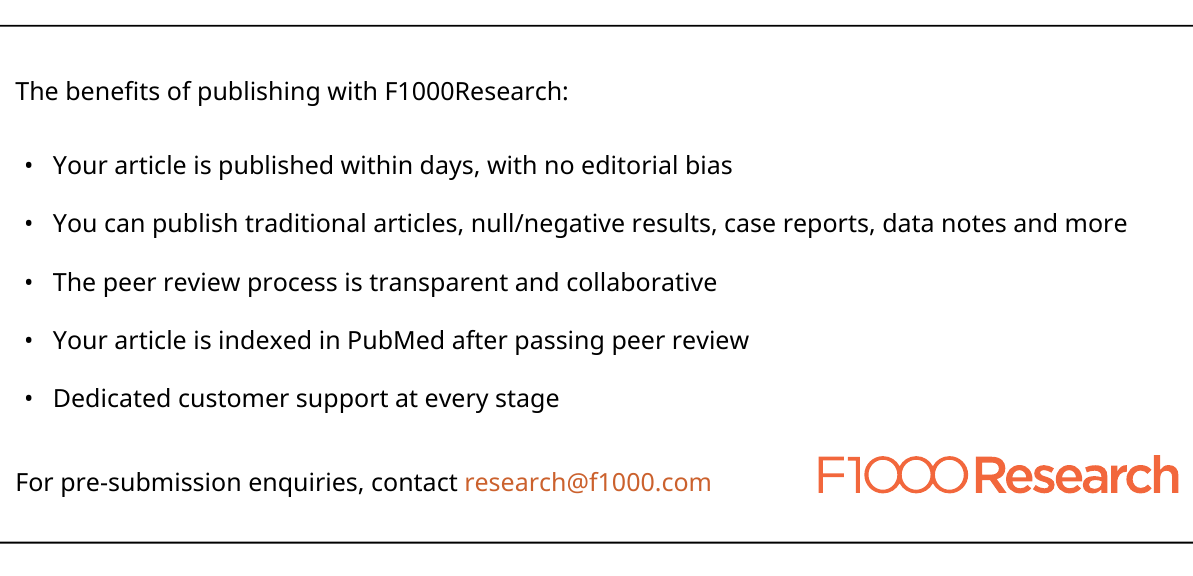
Fig 4 and the related text in “Methods” and “Results and discussions” chapters: Some details related to “high performance liquid chromatographic analysis” is badly missing, such as the specific name of the method, the data of column, the eluting media, and at least an approximated molecular size of the two active fraction 1,862 and